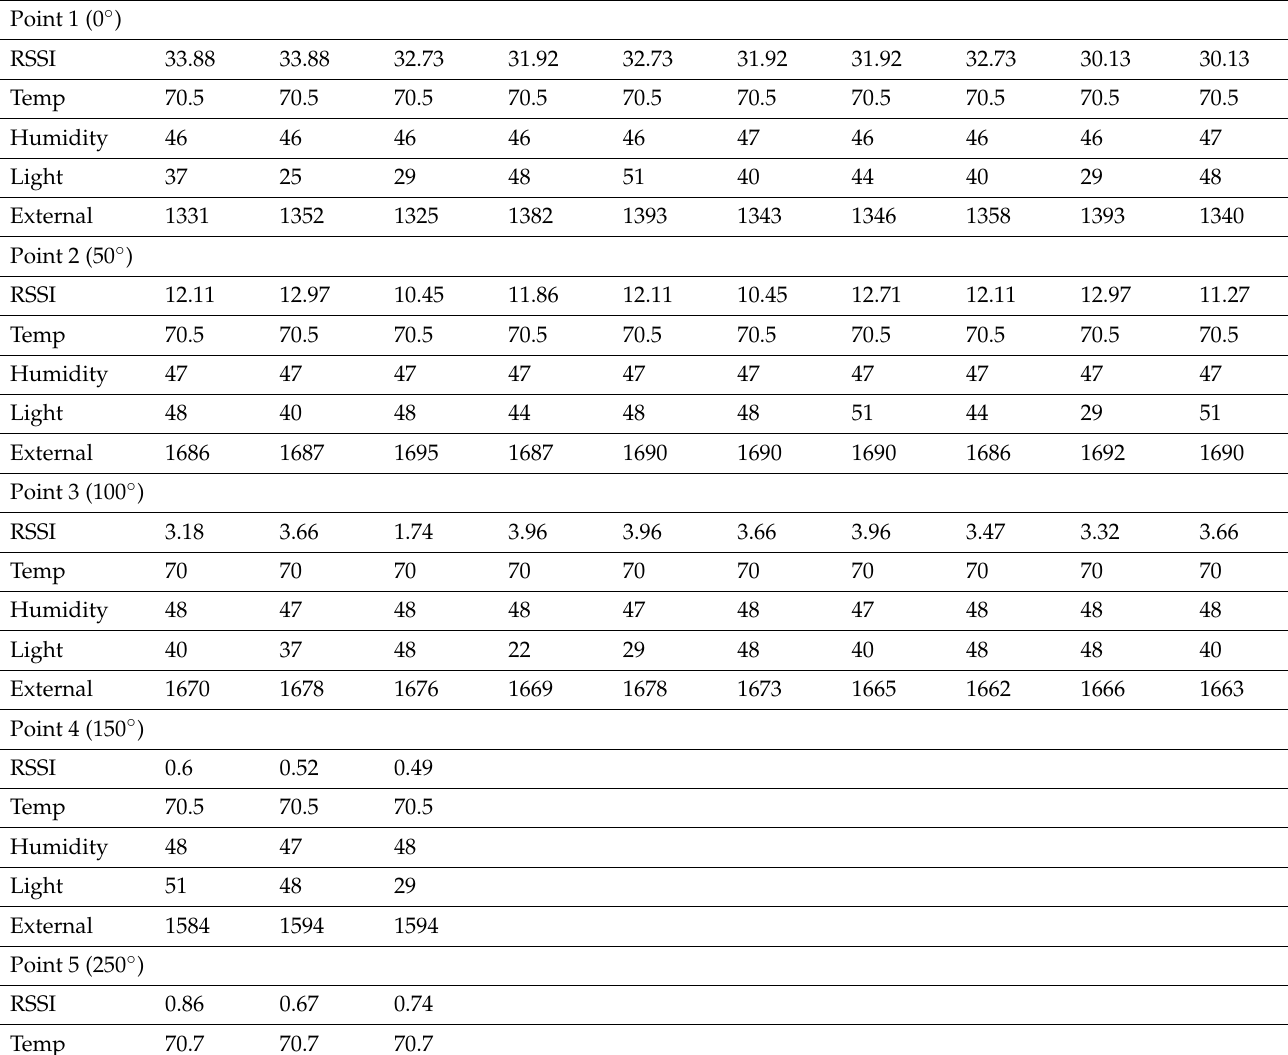
Table 1. Patch Antenna Sensed